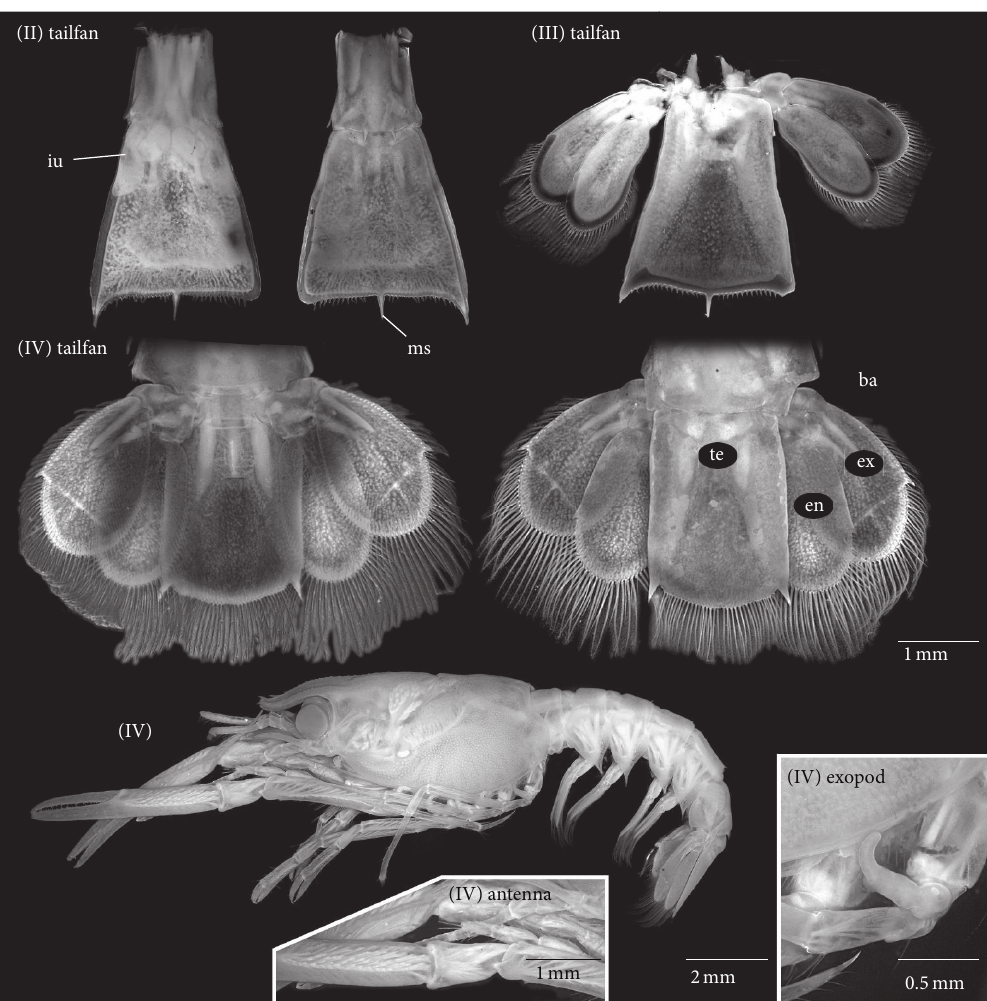
Figure 11: Tailfan of larval stages (II) to (IV) and variability of stage (IV) of Homarus gammarus . (II) Tailfan in ventral (left) and dorsal (right) view; note initial uropods visible through the cuticle. (III) Tailfan in dorsal view. (IV) Tailfan in ventral/anterior view (left) and dorsal/posterior view (right). Note the joint within the exopod paddle (diaresis) marked by arrow. (IV) Overview in lateral view; close-up on antenna which is significantly shorter than in the specimen in Figure 1; close-up on proximal region of thoracopods with a still quite long exopod remain. ba = basipod; en = endopod; ex = exopod; iu = initial uropod; ms = median spine; te =